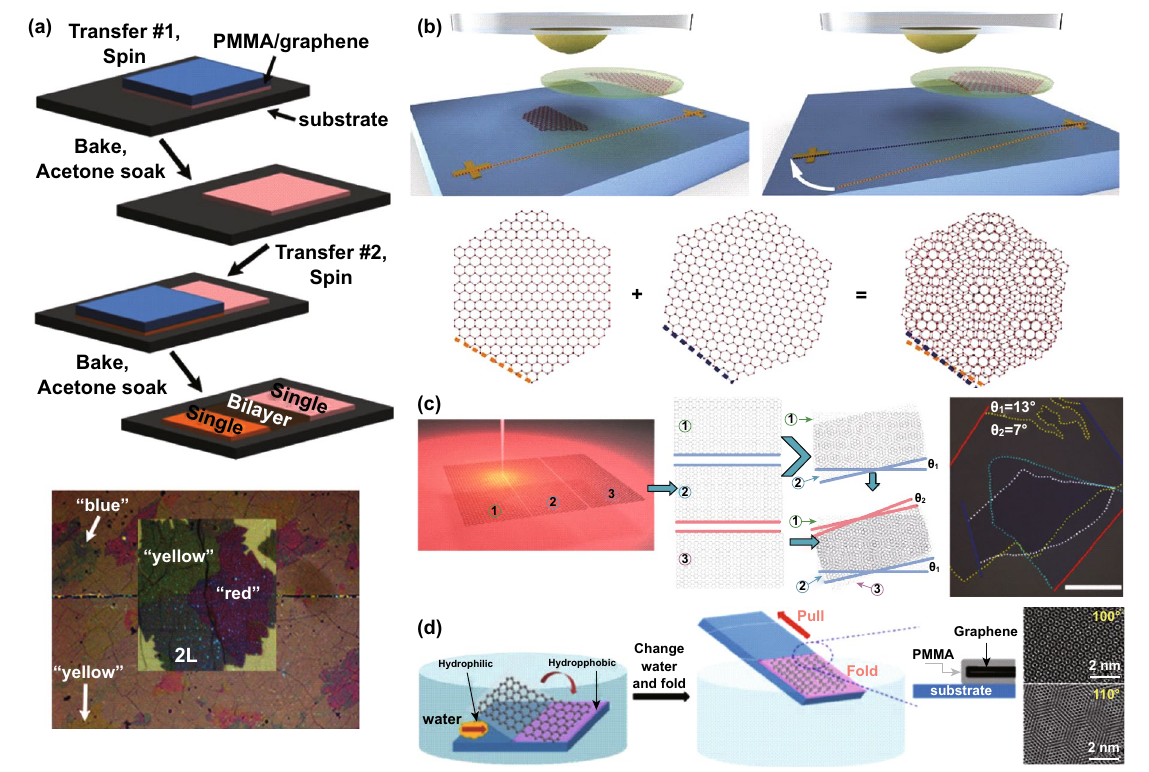
Fig. 1 a Schematic of the synthesis process flow of twisted bilayer graphene (tBLG) by CVD and optical microscope image of tBLG on SiO 2 / Si substrate [75]. b Schematic illustration of detaching an SLG using a hemispherical handle and schematic illustration of the moiré pattern for- mation [79]. c The schematic of the CRS method utilized to fabricate tBLG, double twisted trilayer graphene (DTTG), and optical microscopy image of DTTG [81]. d The schematic of the folding procedure of a single-layer graphene sheet with folding driven by delamination only from the hydrophilic surface region, and the removal of polymers and HRTEM images of tBLG on a SiO 2 /Si substrate with twisting angles (100° and 110°) [82]. Adapted with permission from Refs. [75, 79, 81,